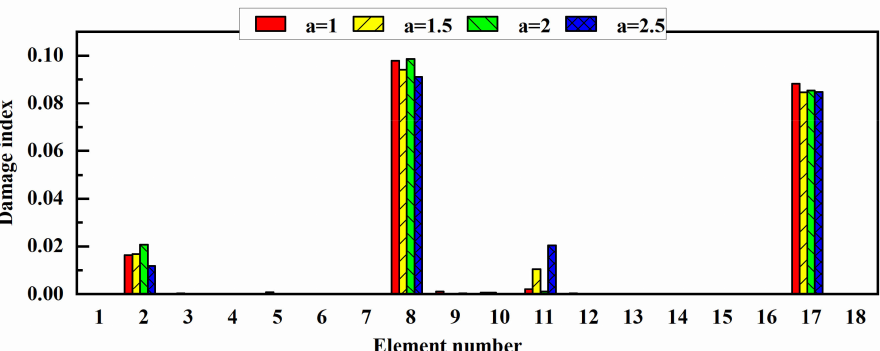
Figure 3. Structural damage detection results under different values of parameter a of the SIPSO algorithm. (Double damages with 10% damage index under 10% noise level).